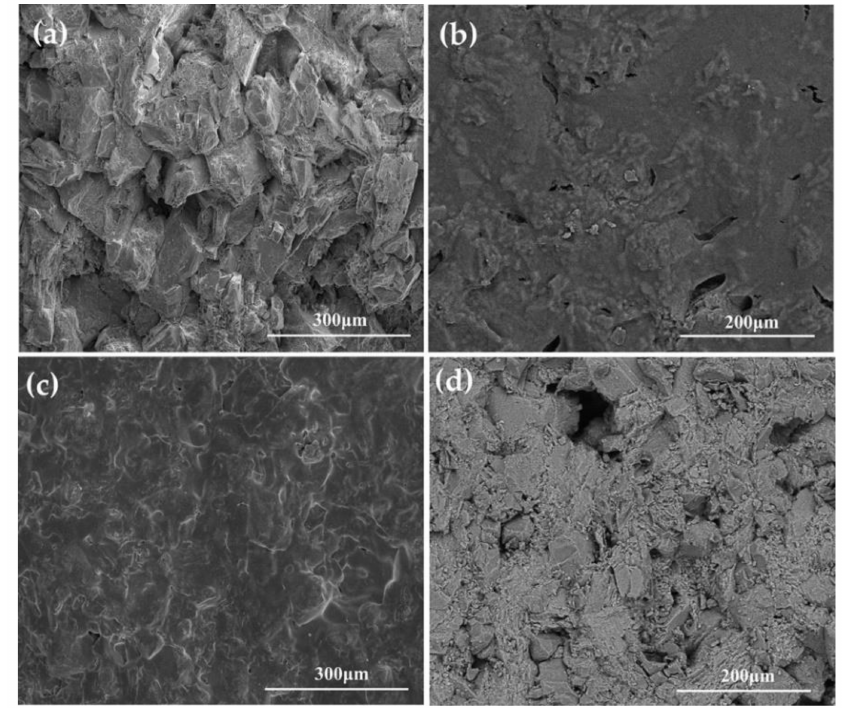
Figure 3. SEM micrographs of sandstone before and after coating with different materials: ( a ) sample Blank, ( b ) sample SiON, ( c ) sample B72, and ( d ) sample